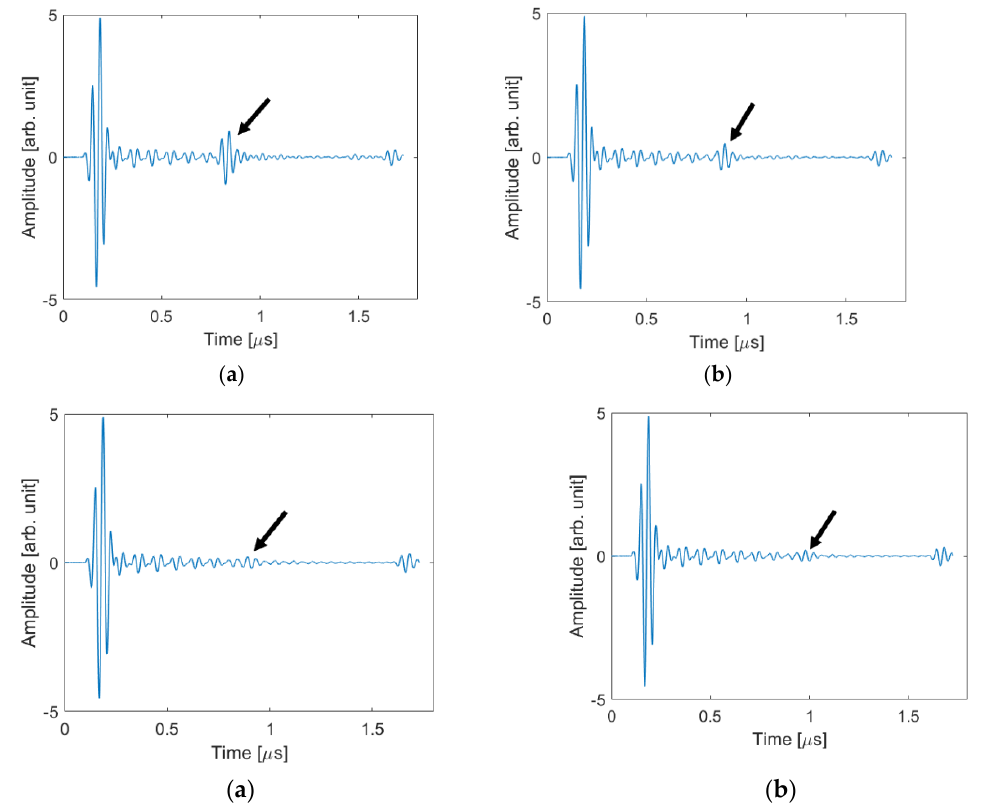
Figure 7. A-scan signals for the different simulated defects: ( a ) total debonding; ( b ) delamination; ( c ) foreign body (grease); ( d ) broken fibers.